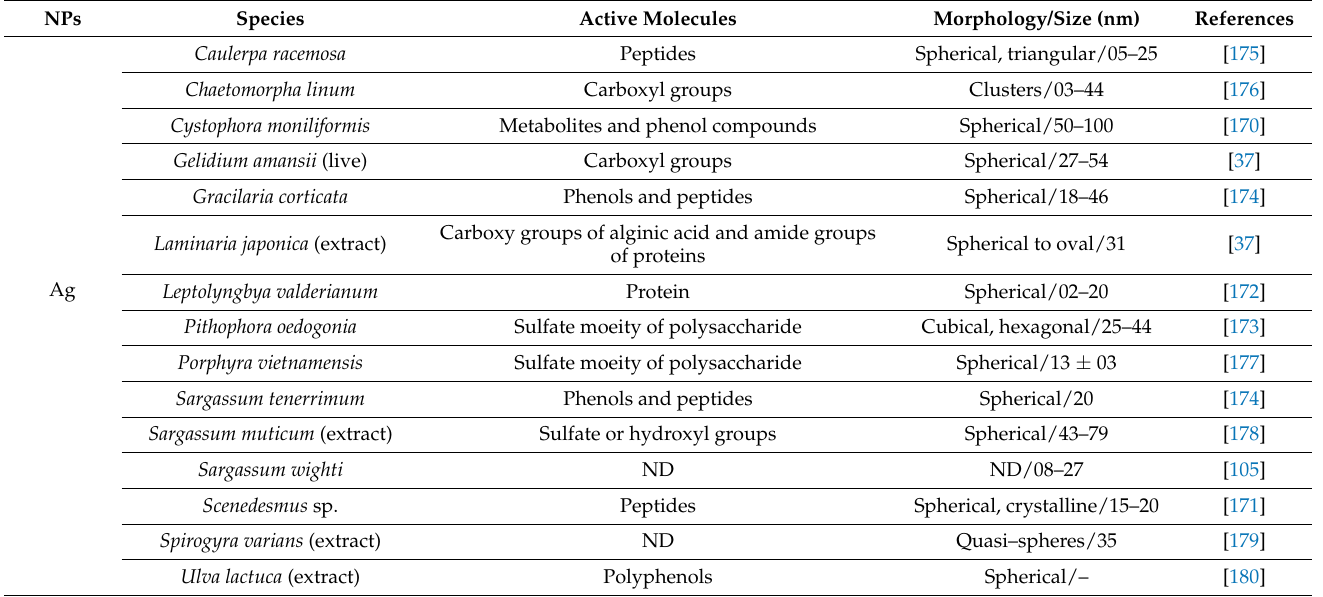
Table 4. Nanoparticles produced by